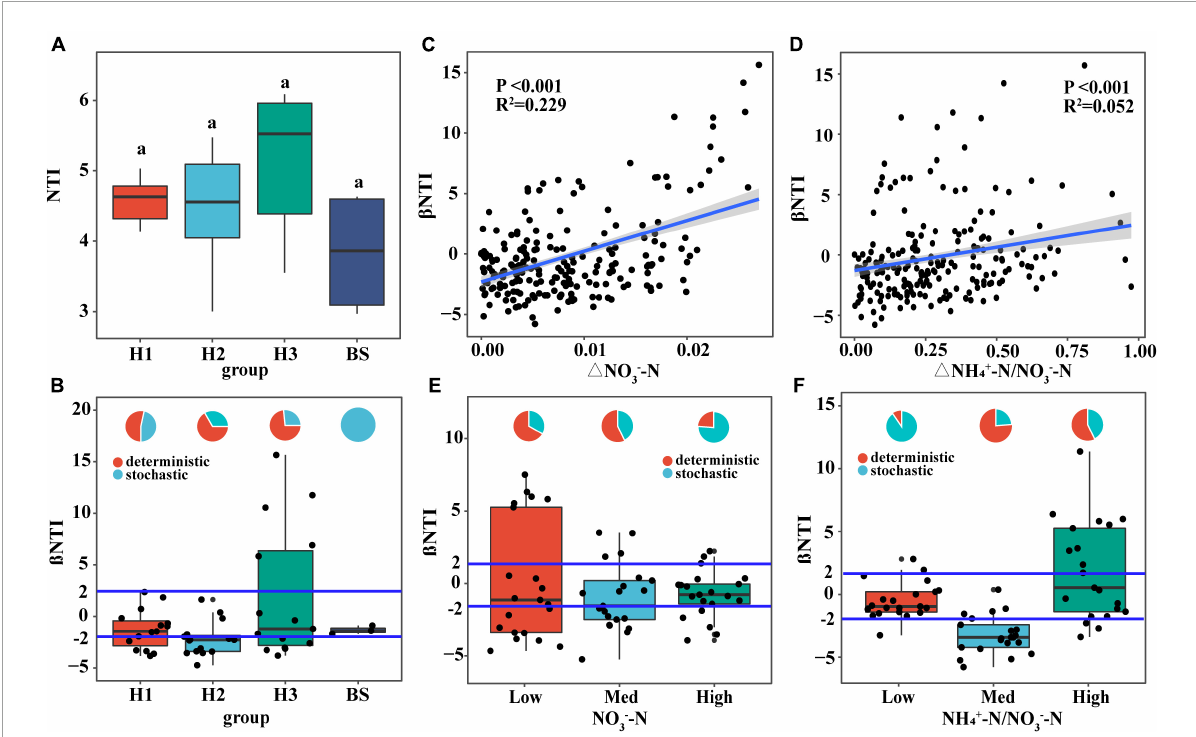
FIGURE7 The relationship between the available nitrogen and the assembly of soil bacterial communities. Distribution of NTI value (A) and β NTI value (B,E,F) of soil bacteria community, and the relationship of β NTI value (C,D) with the difference of NO 3 − -N content and NH 4 + -N/NO 3 − -N. The small graphs in panels (B,E,F) represent the proportions of stochastic and deterministic processes in different groups of bacterial